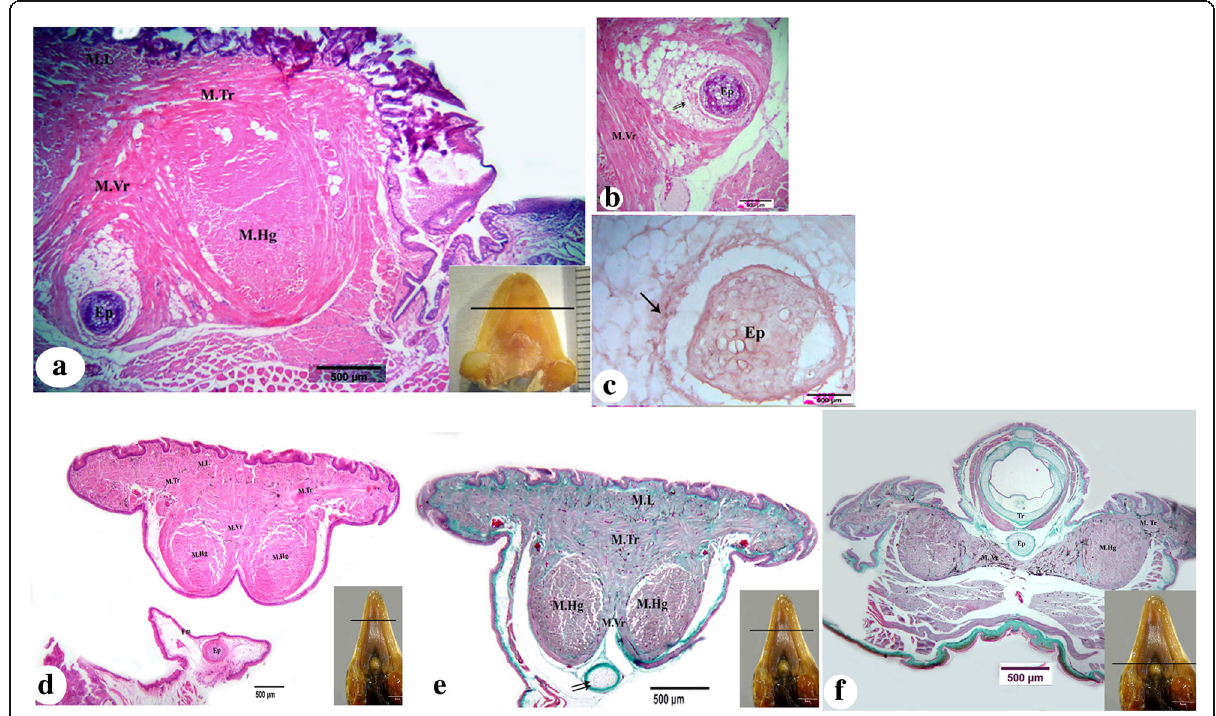
Fig. 2 a Photomicrograph of transverse section through the posterior half of the mid tongue of P. guttatus showing entoglossus (Ep), hypoglossus muscle (M.Hg), verticalis muscle (M. Vr), transveralis muscle (M.Tr), and tongitudinalis muscle (M.L). b , c High magnification shows fatty connective tissue (double arrows) and elastic fibers (arrow) around the entire posterior length of the entoglossus process (Ep). d , e Photomicrograph of transverse section through the free portion and f through the posterior portion of the tongue of A. boskianus showing the position of entoglossus process (Ep) and its posterior extension ventral to the trachea (Tr), topographic position of the hypoglossus (M.Hg), verticalis muscle (M. Vr), transveralis muscle (M.Tr), and collagen fibers (double arrow). b , d Stain by H&E. c Stain by orcein. e , f Stain by Masson ’ s trichromic stain. Scale bar 500 μ